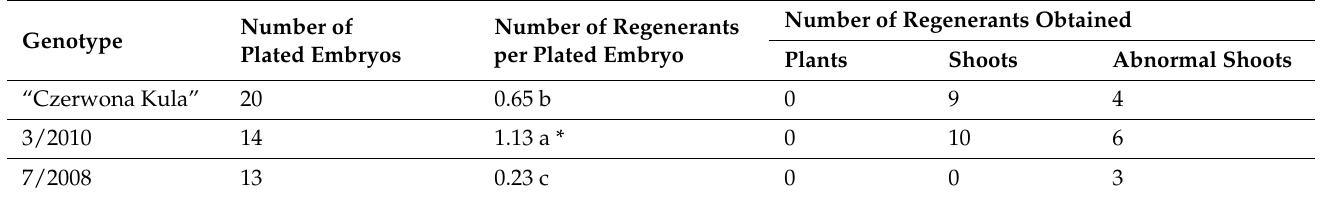
Table 6. Effect of genotype on the number of regenerants obtained on MS medium containing